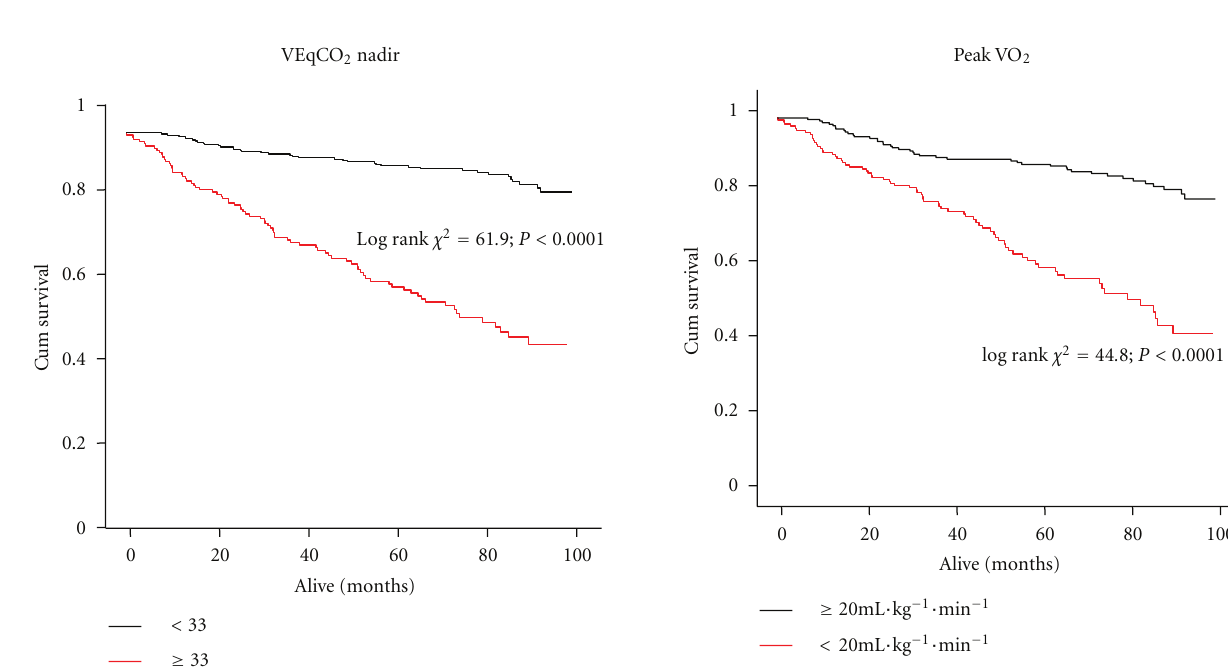
Figure 5: Kaplan-Meier survival curve showing VEqCO 2 nadir- data dichotomised by optimal cut-points ( < 33 n = 252 patients, event free survival 85%; ≥ 33 n = 171 patients, event free survival 54%).